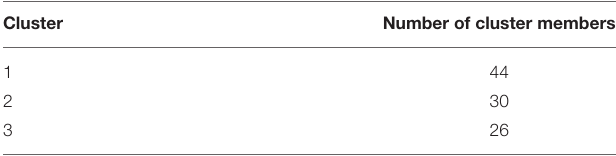
TABLE 5 | Remaining normality assumption test results.